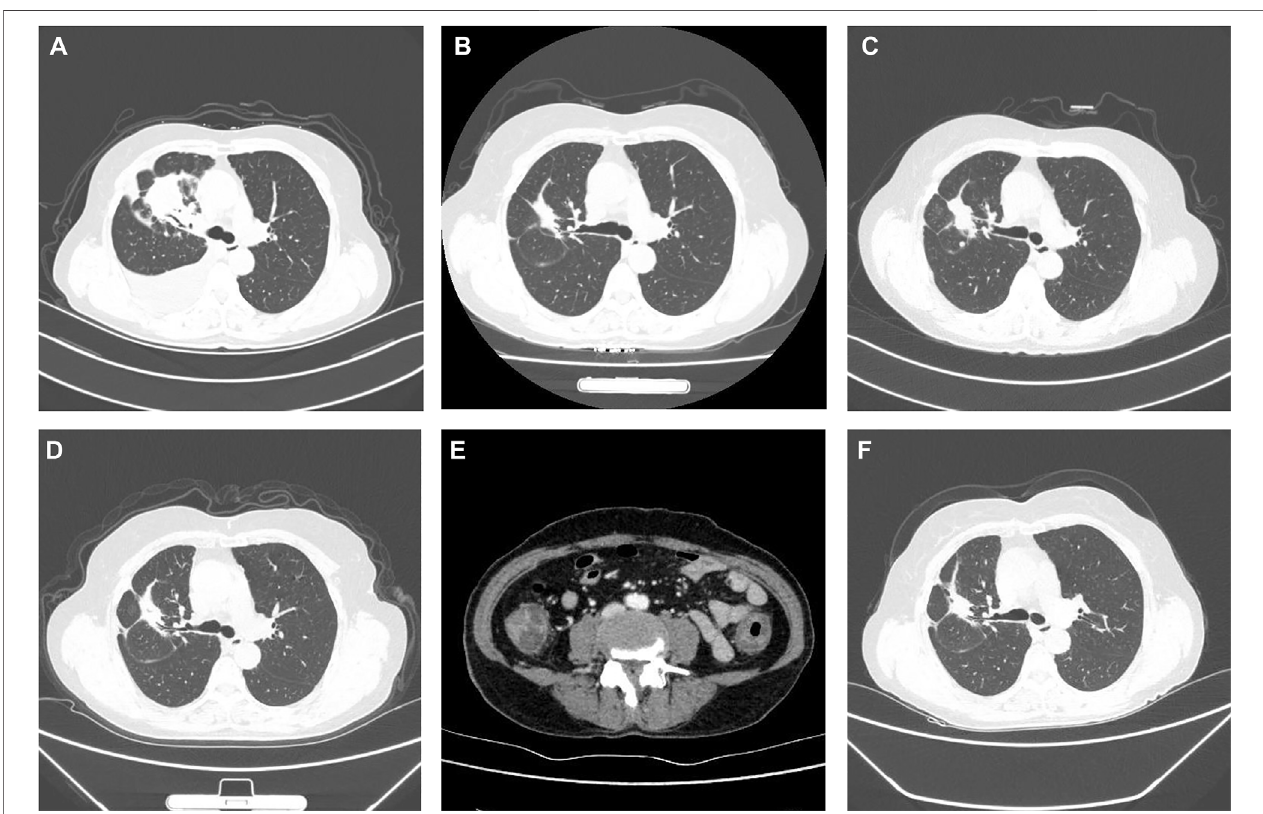
FIGURE1 | Clinical course according toCTscans. (A) Baseline CTscan at diagnosisin October 2019. (B) PR on icotinib in June 2020. (C) Disease progression in October2020. (D) PRtoosimertinibinJanuary 2021. (E) AbdomenandpelvisCTinJune2021showedthatoedemahadcausedwallthickening ofthecolon. (F) SDon aumolertinib in November